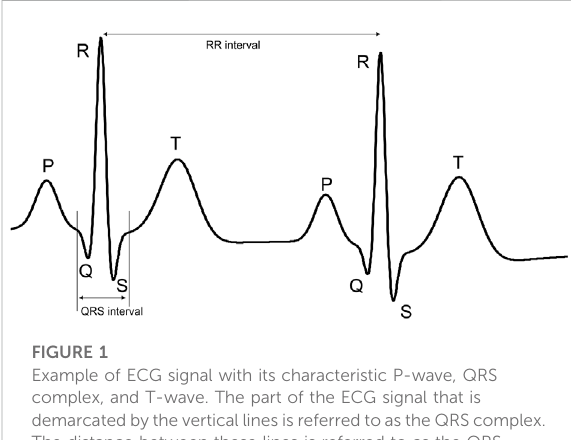
FIGURE 1 Example of ECG signal with its characteristic P-wave, QRS complex, and T-wave. The part of the ECG signal that is demarcatedby the vertical lines is referred to as the QRS complex. The distance between these lines is referred to as the QRS interval. The length of thisinterval isused to de fi nethe kernel sizes of some layers in the proposed neural